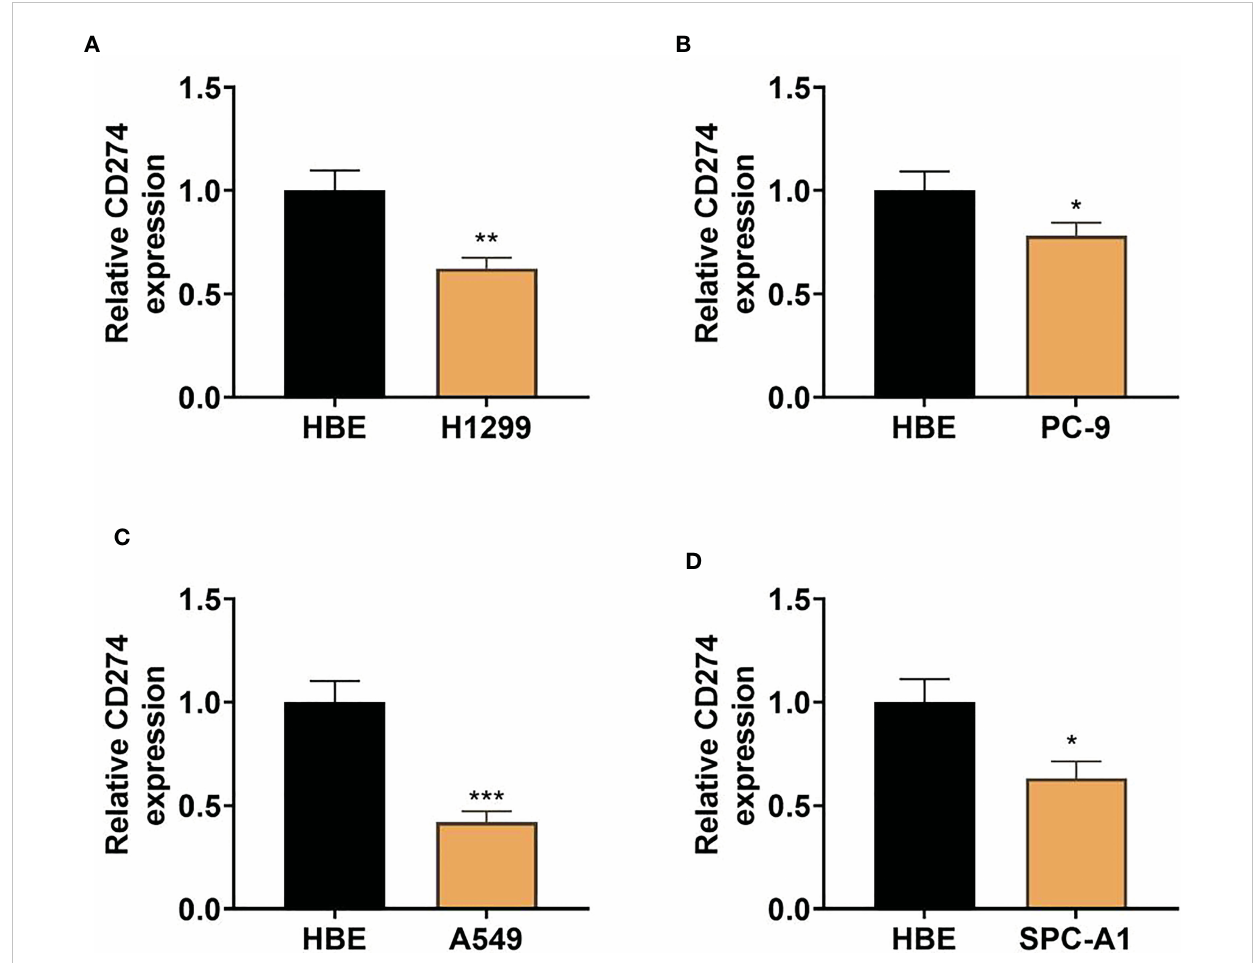
FIGURE 7 Expression of CD274 in human LUAD cell lines (H1299, PC-9, A549, and SPC-A1) and normal human lung epithelial cell lines (HBE) (A – D) : qRT-PCR to detect CD274 expression in human LUAD cell lines (H1299, PC-9, A549, and SPC-A1) after transfection with pcDNA empty vector and pcDNACD274. *P < 0.05 **P < 0.01 and ***P < 0.001 as determined by two-tailed